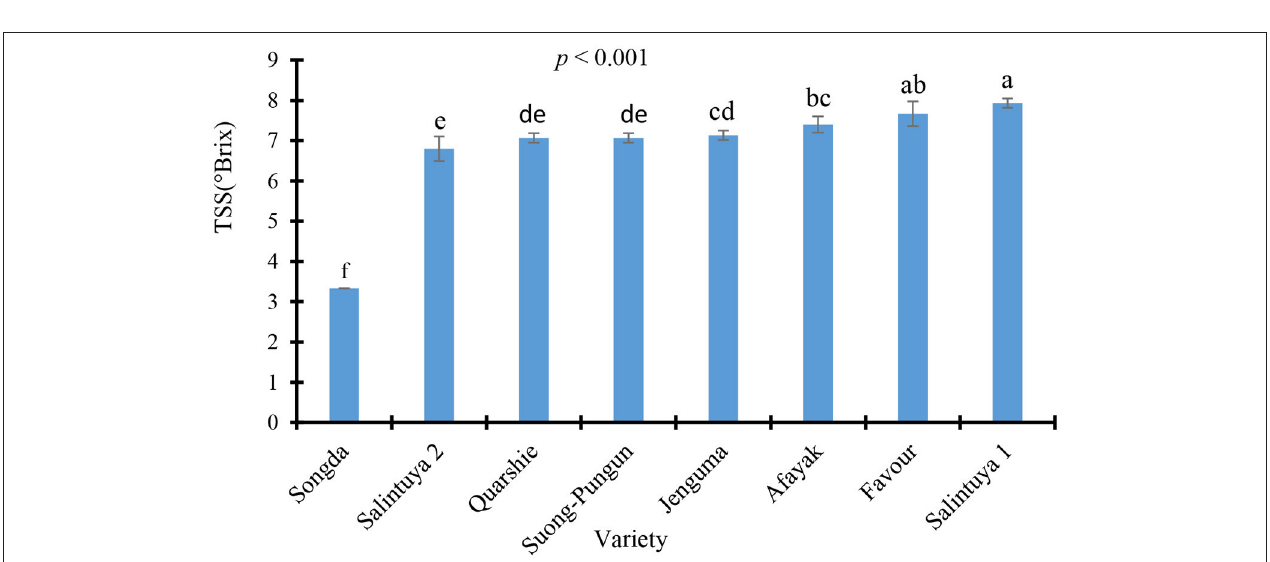
FIGURE 3 | Total soluble solids of soymilk as affected by soybean variety. Bars are means ± SD; n = 3. Different letters on top of bars represent statistical differences after ANOVA and means compared using LSD test ( p < 0.05).